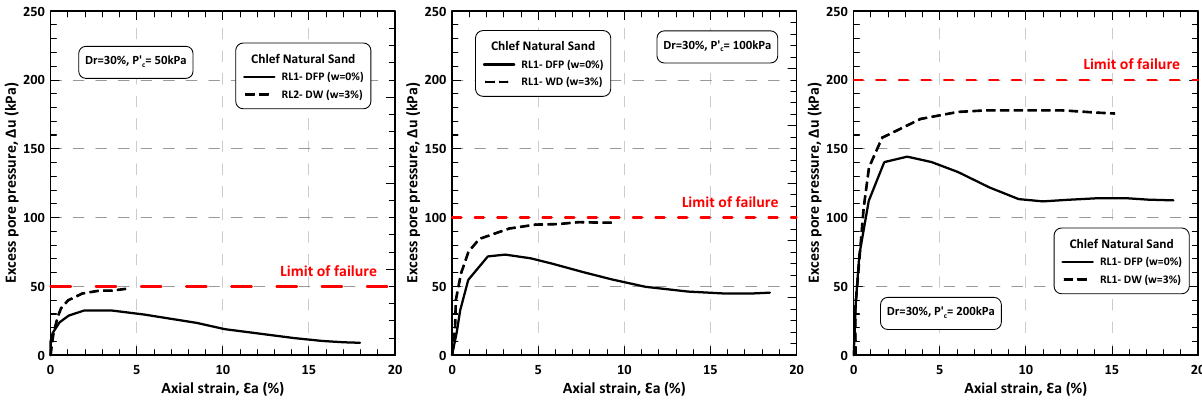
Fig. 10 Excess pore water pressure versus axial strain curves of sand reinforced with one layer of geotextile under different confining pres- sures: a p ′ = 50 kPa, b p ′ = 100 kPa, and c p ′ = 200 kPa c c c